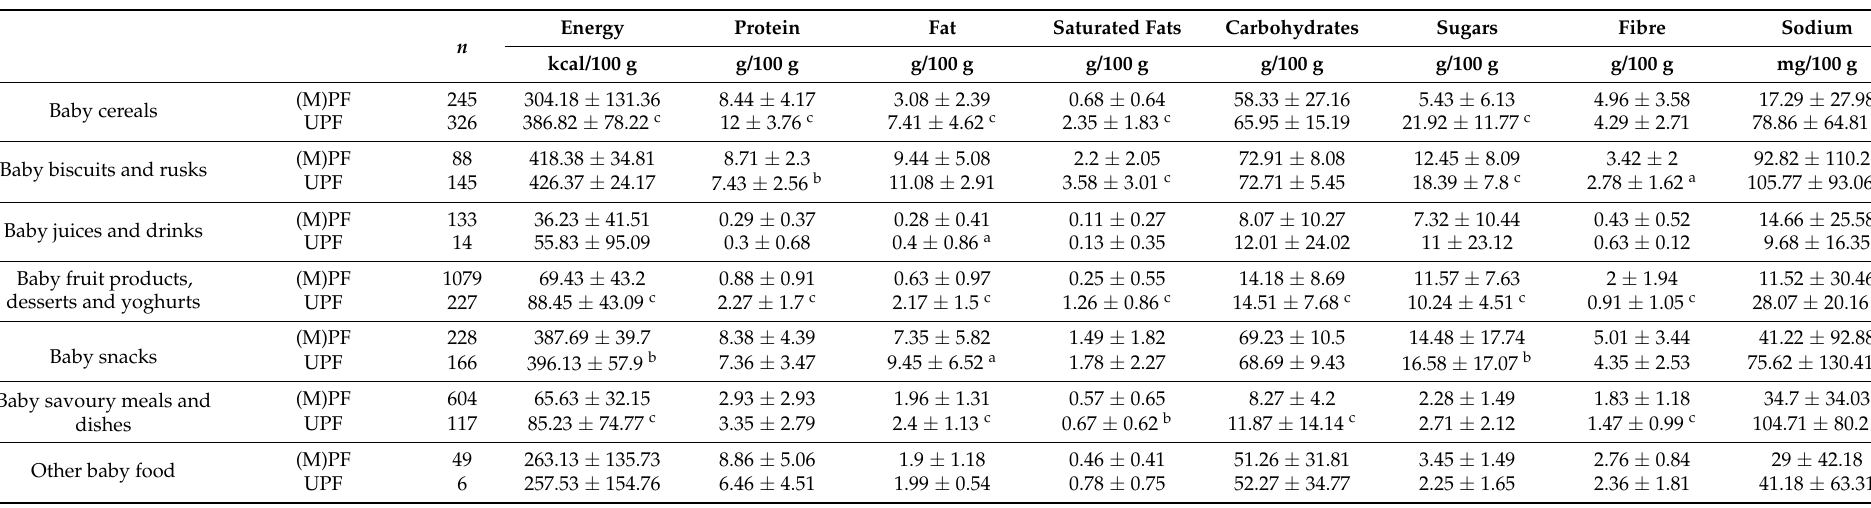
Table 4. Comparison of energy and nutrient content (mean ± s.d.) between minimally processed/processed foods and ultra-processed foods, by baby food subcategory. Energy Protein Fat Saturated Fats Carbohydrates Sugars Fibre Sodium n kcal/100 g g/100 g g/100 g g/100 g g/100 g g/100 g g/100 g mg/100